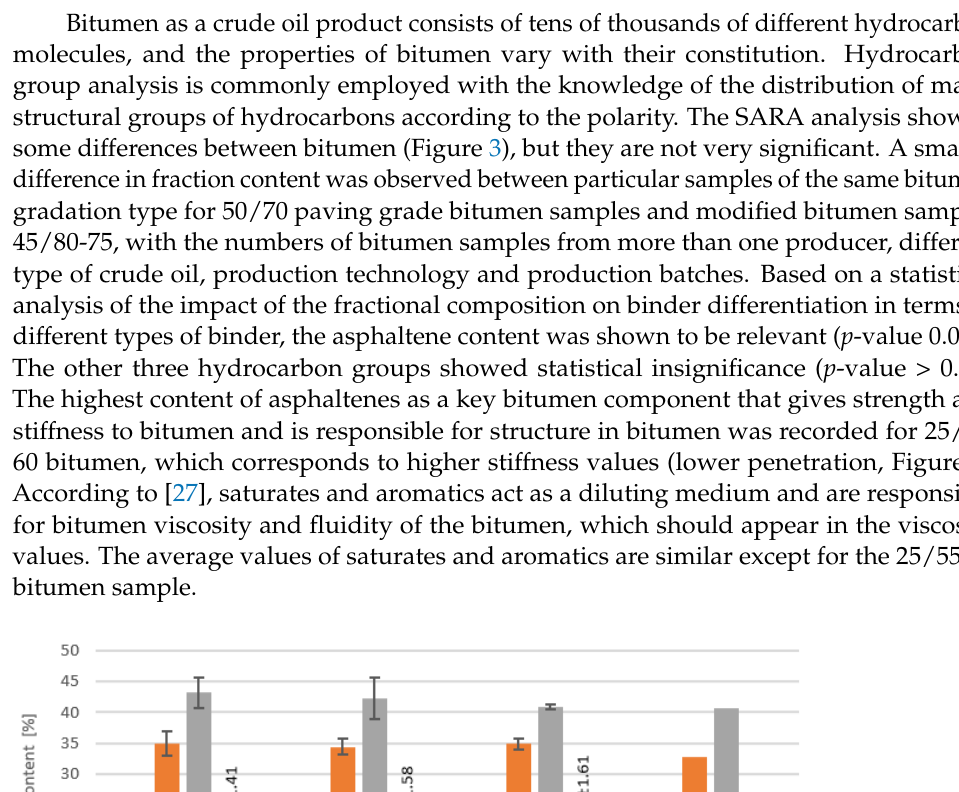
Figure 2. Elemental analysis (CHNS and O content) results of tested bitumen samples.